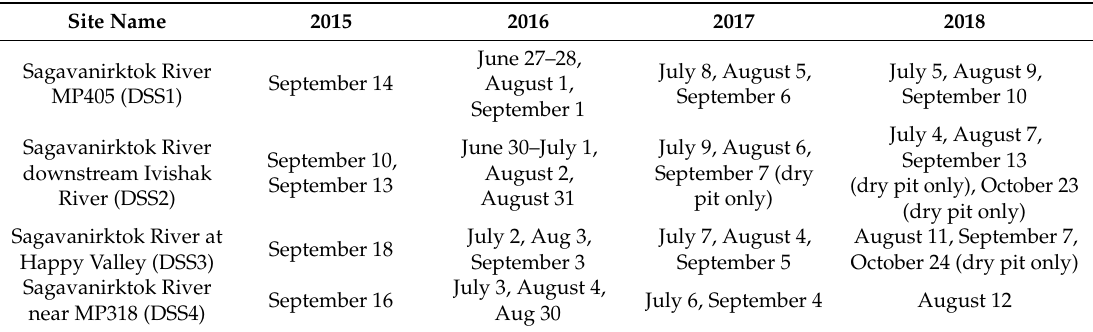
Table 1. Date of bathymetric surveys at pits.